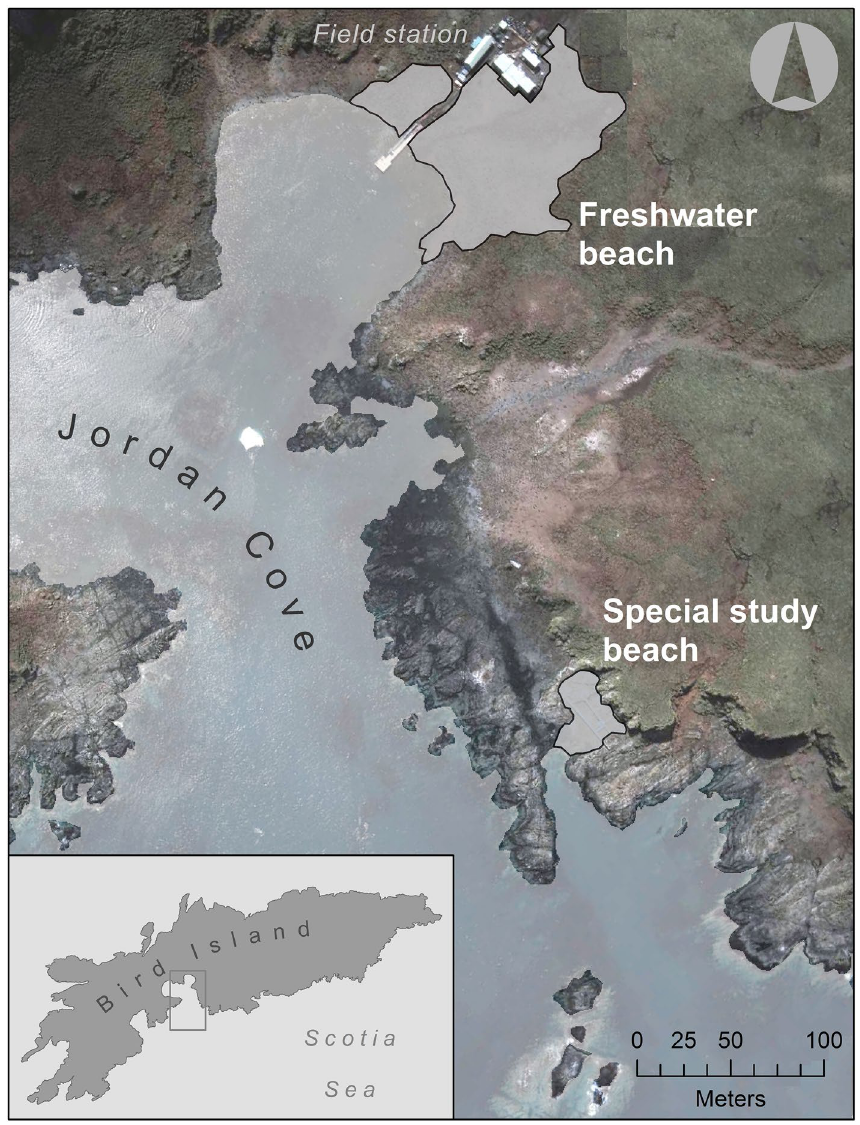
10.3, ESRI, Redlands, CA, USA, https:// www. esri. com/ en- us/ home) using open source data from Natural Earth Data (https:// www. natur alear thdata.